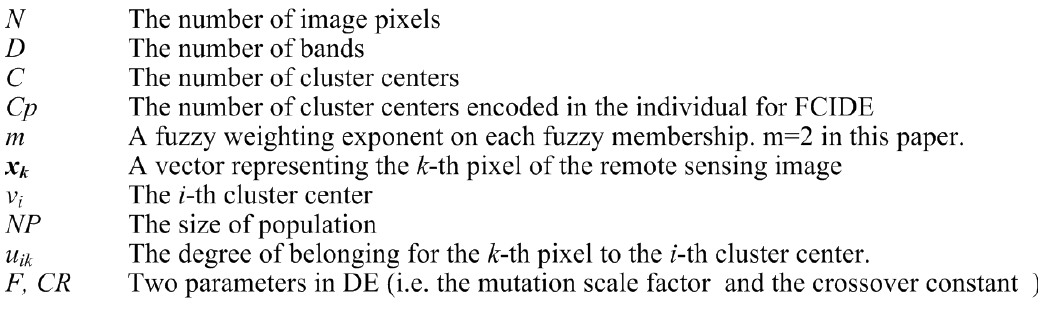
Figure 1. The defined notations.